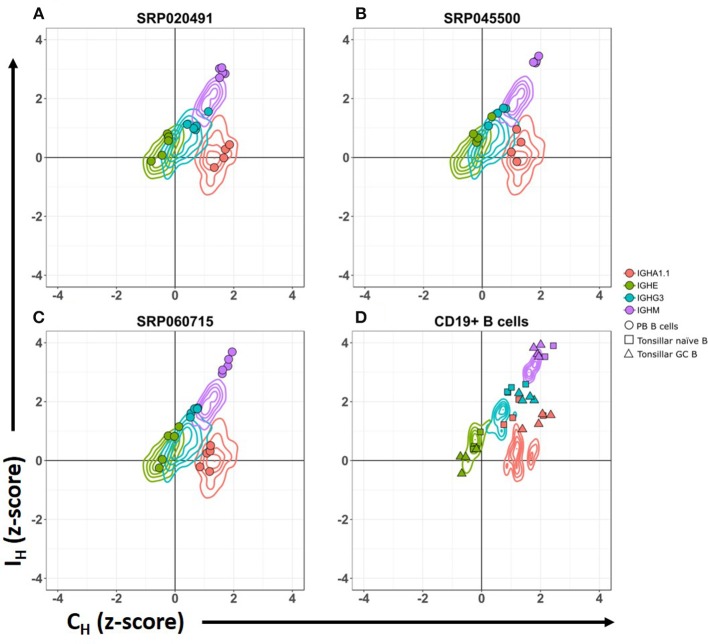
CSRnc transcription pattern in whole blood is similar to peripheral blood sorted CD19+ B cells. Relative CSRnc and CH transcription (Z- score) in whole blood RNA from the GTEx dataset is shown as a 2-D contour plot (n = 456 samples) in (A–C). Filled colored circles correspond to Z-scores of peripheral blood sorted CD19+ B cells derived from three independent RNA-seq projects (28, 29), overlaid to the GTEx data (Table S1). (D) 2-D density data of sorted CD19+ peripheral blood B cells Z-values of the projects shown in A–C (n = 14), overlaid with the corresponding Z scores of sorted tonsillar naïve B cells (squares. n = 4) and tonsillar germinal center B cells (triangles. n = 4) from project SRP021509 (27).